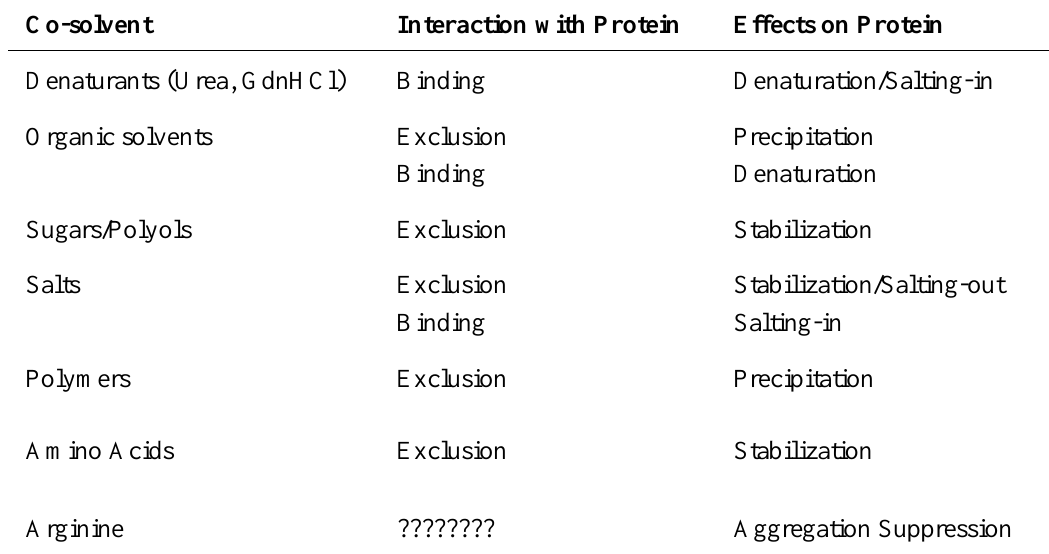
Table 1. Mode of preferential interaction of proteins with various